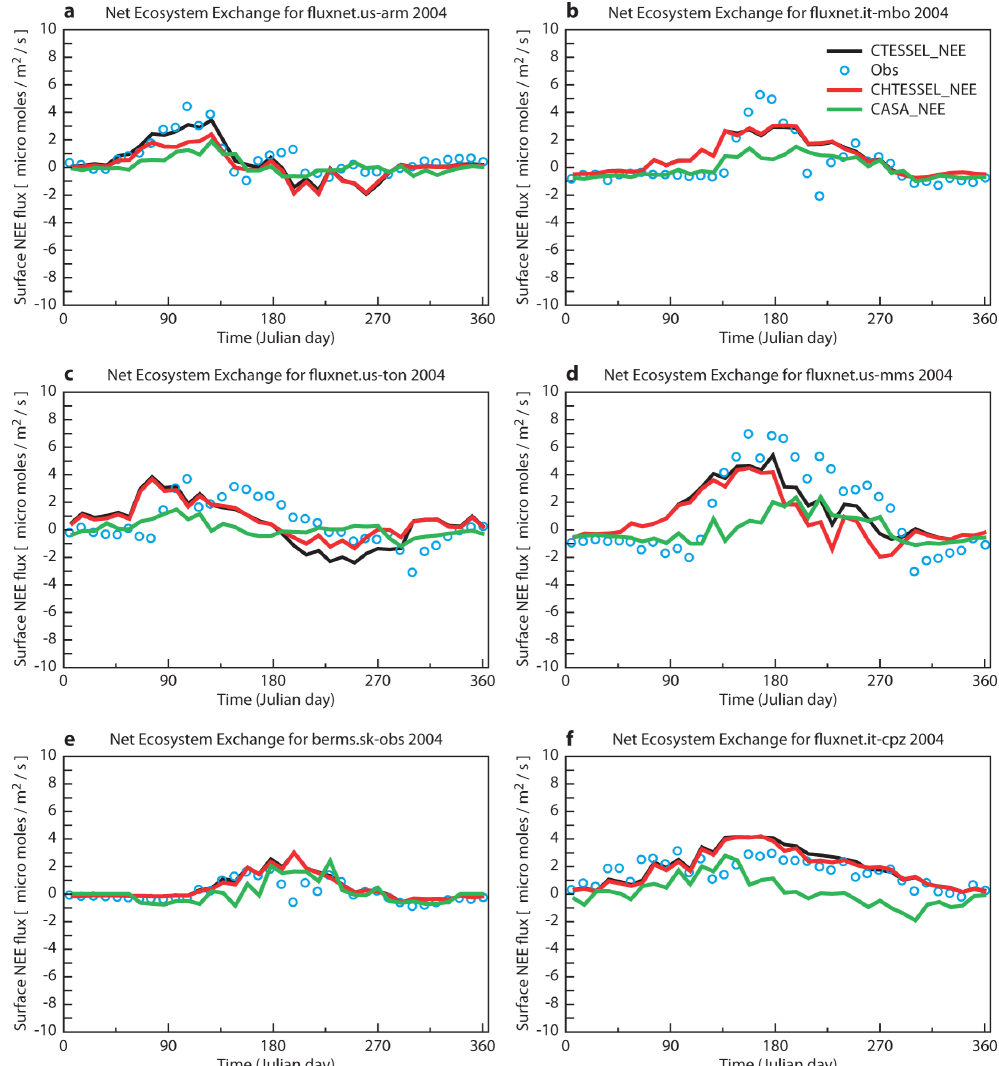
Figure 12. Seasonal cycle (2004) of 10-day averaged offline simulated (lines) and observed (blue dots) Net Ecosystem Exchange µ mol m − 2 s − 1 for C-TESSEL (with A-gs, black line), CH-TESSEL (with Jarvis-type evaporation, red line) and CASA-GFED3 (green line) at diverse FLUXNET observational sites in the panels ( a – f ) representative of different biomes: ( a ) Southern Great Plains site-Lamont, US; ( b ) Monte Bondone, Italy; ( c ) Tonzi Ranch Sierra Nevada, US; ( d ) Morgan Monroe State Forest, US; ( e ) Saskatchewan Western Boreal, Mature Black Spruce forest, Canada; ( f ) Castelporziano, Italy. Correlations coefficients of the two components of NEE, GPP and Reco, compared with tower observations (0.8 for both fluxes, on average over 34 sites) indicate much higher skill and confirm the robustness of these results. NEE is a small residual of GPP and Reco; therefore, a correlation coefficient above 0.6 is highly relevant. Again, C-TESSEL and CH-TESSEL show similar performance, with site to site variability attributed to representativity of the model grid-box [148]. CH-TESSEL has also been evaluated in coupled integration mode for the 2003 to 2008